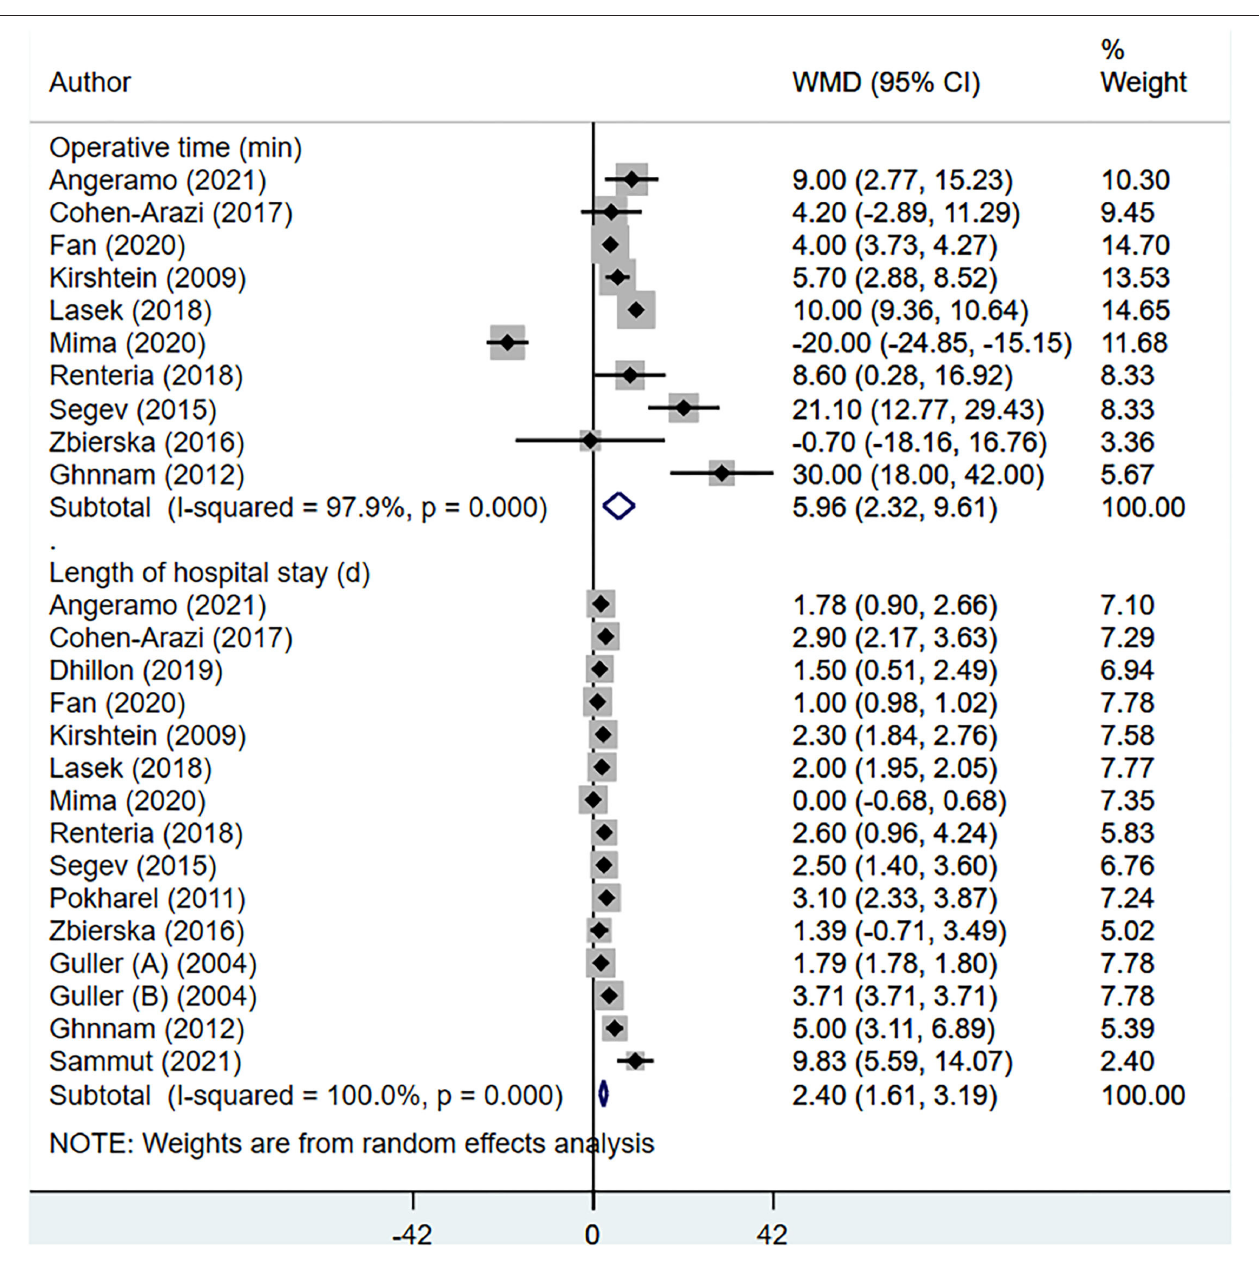
FIGURE 2 | Operative time and length of hospital stay among elderly subjects, compared to non-elderly subjects.